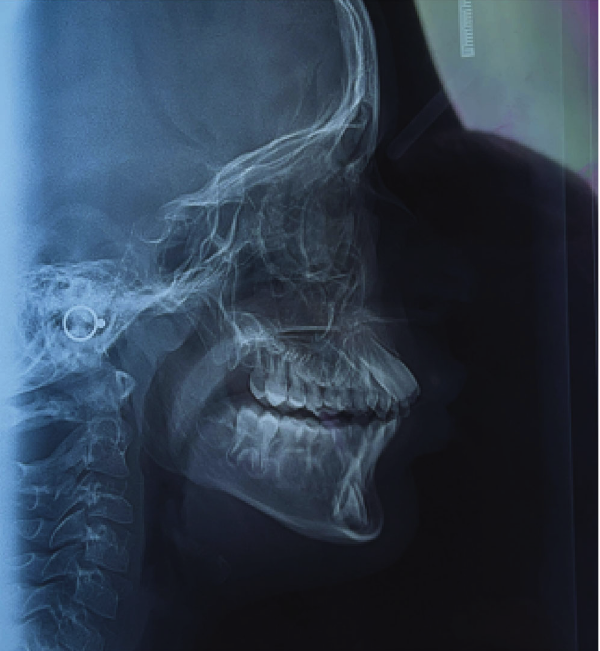
Figure 3: Lateral radiographic view showing skeletal class